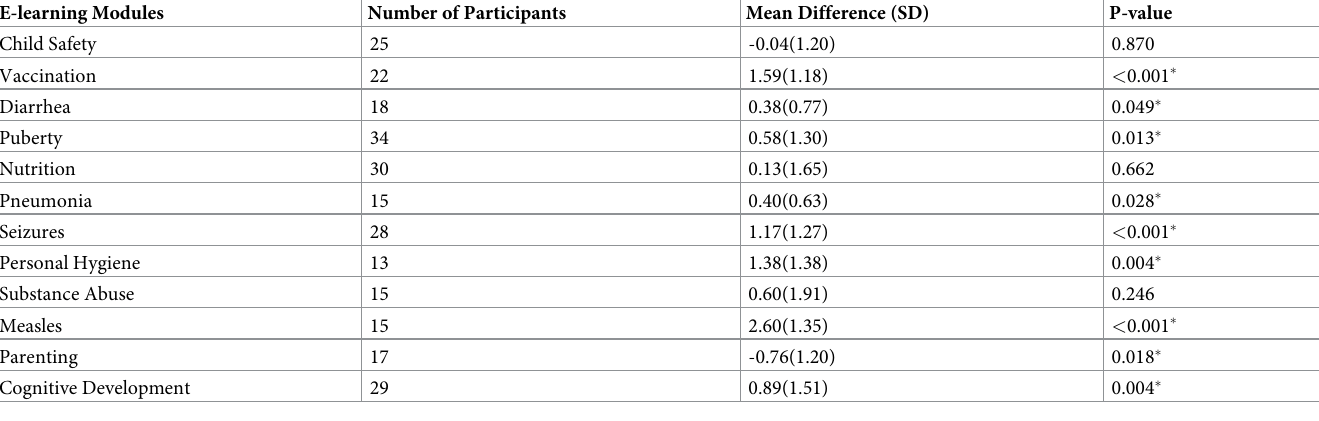
Table 1. Pre & post analysis of e-learning sessions for